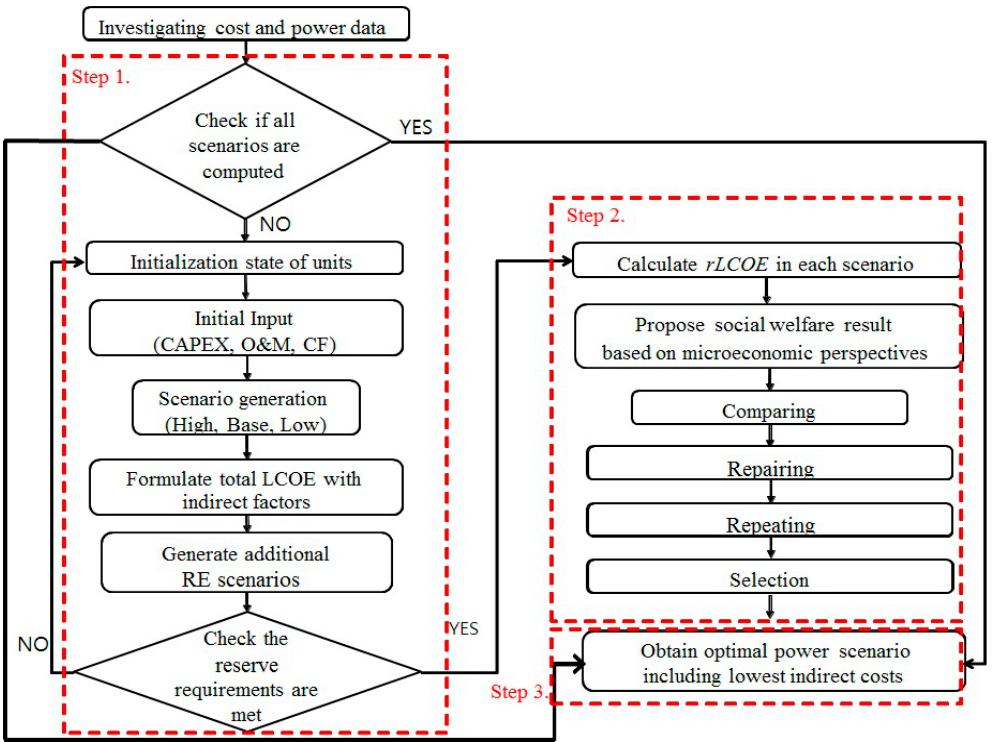
Figure 2. Proposed process of the rLCOE approach.